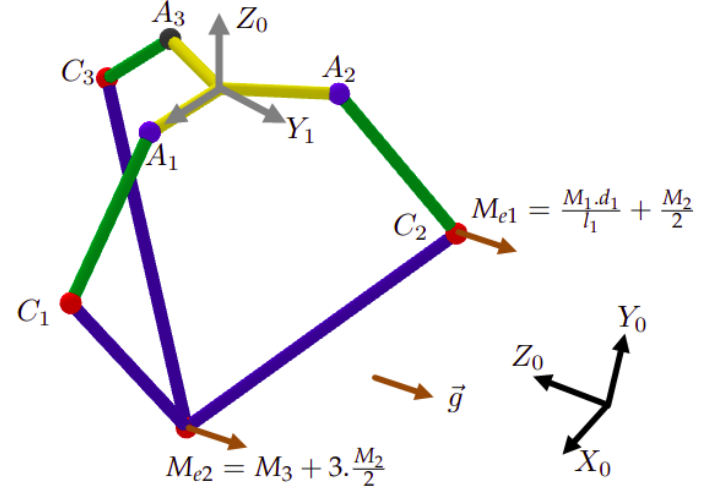
Figure 19. Equivalent